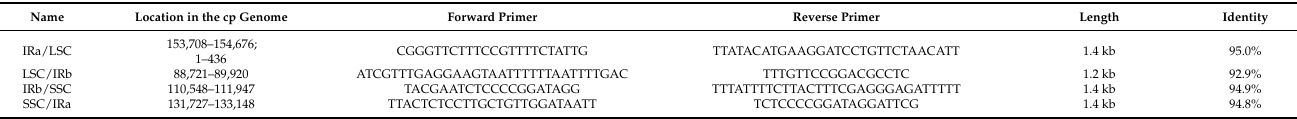
Table 2. List of primer design and identity to the original sequence.